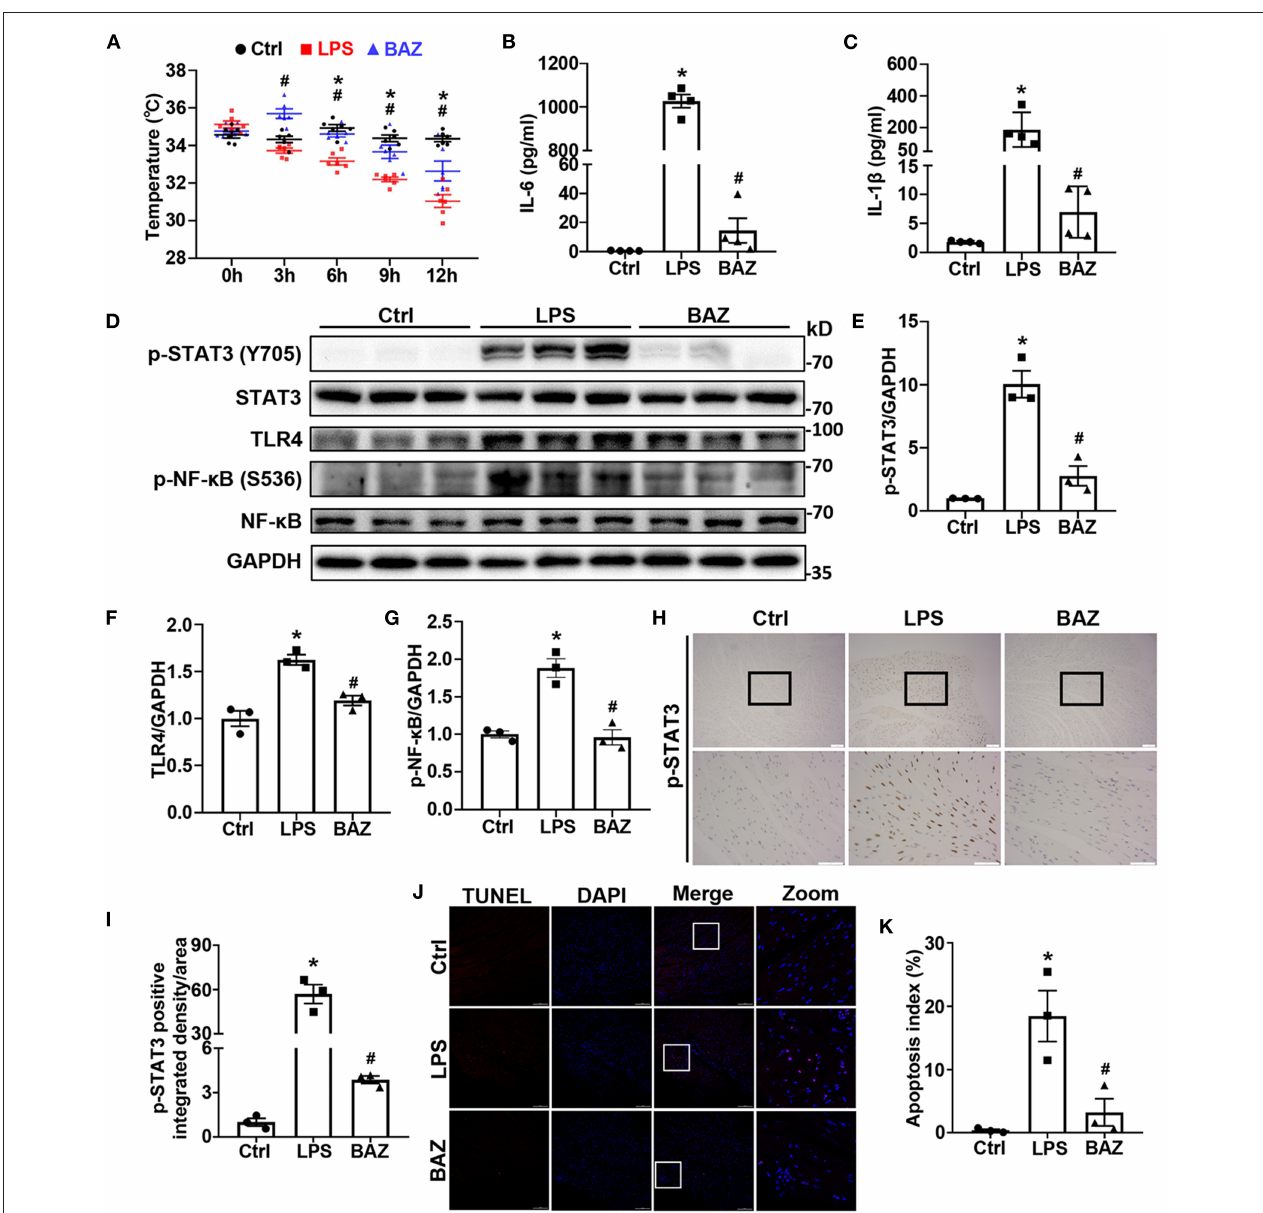
FIGURE 2 | Bazedoxifene attenuated cardiac inflammatory and apoptosis levels in LPS-challenged mice. (A) Body temperature of mice at 0, 3, 6, 9, 12h after LPS treatment. (B,C) ELISA assays were performed to measure IL-6 level (B) and IL-1 β level (C) in mice serum. (D–G) Inflammatory signaling protein levels of p-STAT3 (Tyr705) (E) , STAT3, TLR4 (F) , p-NF κ B (Ser536) (G) , and NF κ B in mice heart tissues were determined by western blot analysis. (H) Representative immunohistochemical images of p-STAT3 (brown spots) in mice heart tissues. Upper scale bar: 100 µ m; Lower scale bar: 50 µ m. (I) Quantification of p-STAT3 positive area. (J) Representative images of TUNEL staining in mice heart tissues. Scale bar: 100 µ m. (K) Quantification of apoptosis Index. n = 6 (A) , 4 (B,C) , and 3 (D–K) per group. Data represent means ± S.E.M. * p < 0.05 vs. control; # p < 0.05 vs. LPS treatment. Statistical analyses were performed using one-way